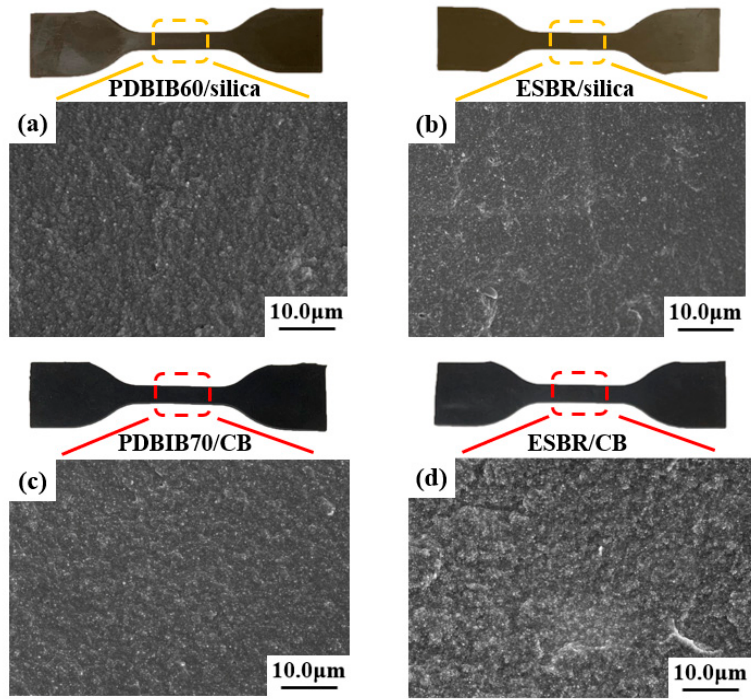
Figure 9. SEM micrographs of ( a ) PDBIB60 / silica, ( b ) ESBR / silica, ( c ) PDBIB70 / CB, and ( d ) ESBR / CB nanocomposites.